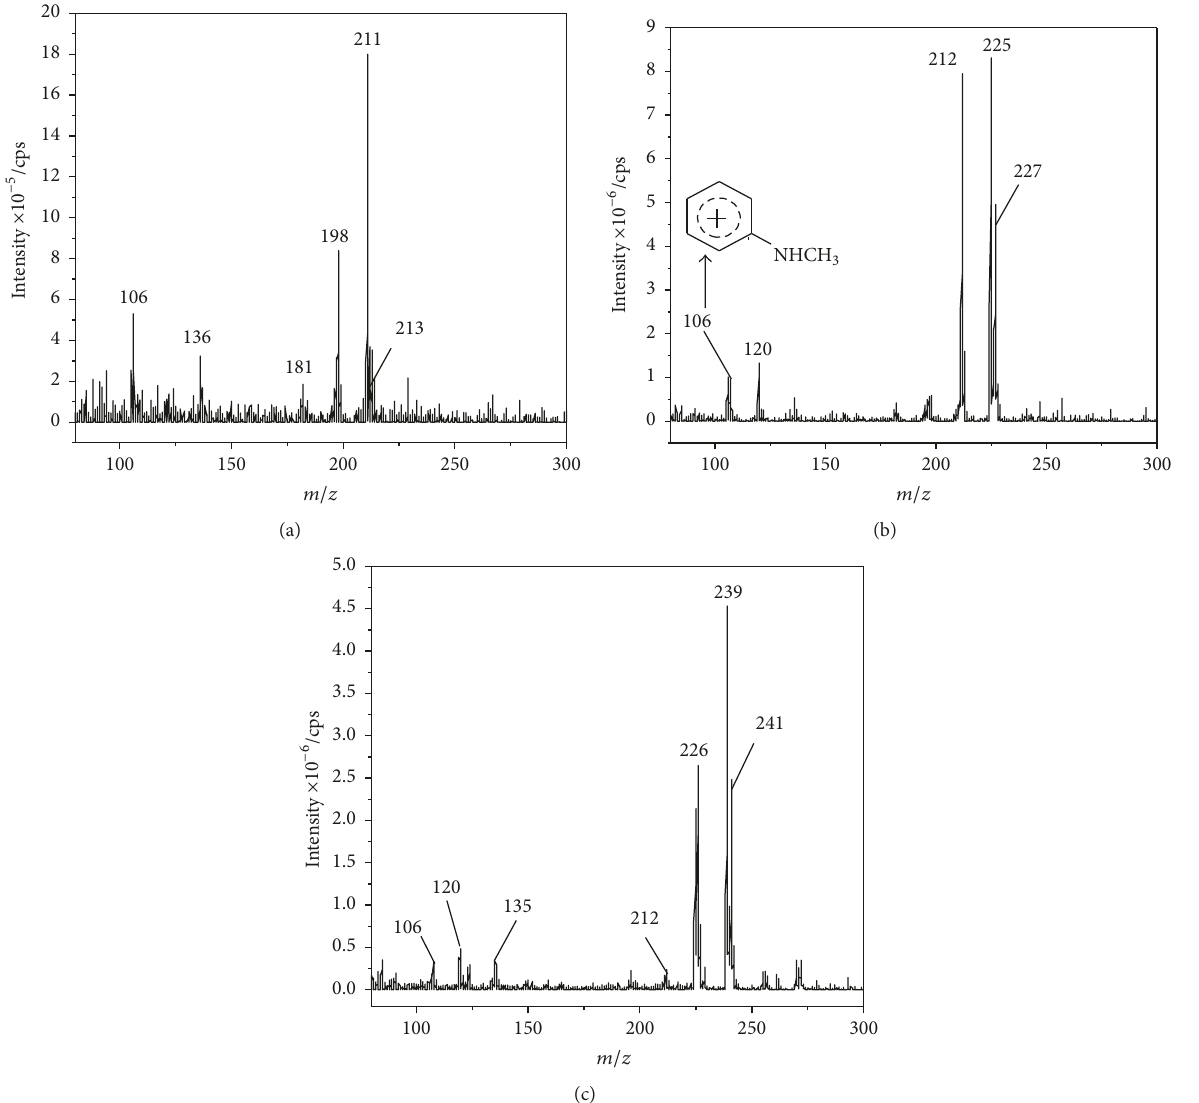
Figure 2: MS spectra of the by-products 1 , 2 , and 3 . Subfigures (a), (b), and (c) present the MS spectra of the pseudomolecular ions of compounds 1 , 2 , and 3 , respectively. 4 stands for the ion with an m/z value of 106.